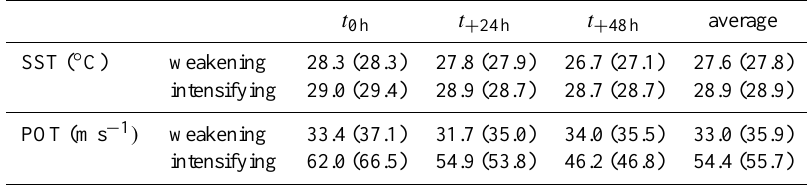
Table 3. The average SSTs and POTs for the weakening and intensifying cases at different times.